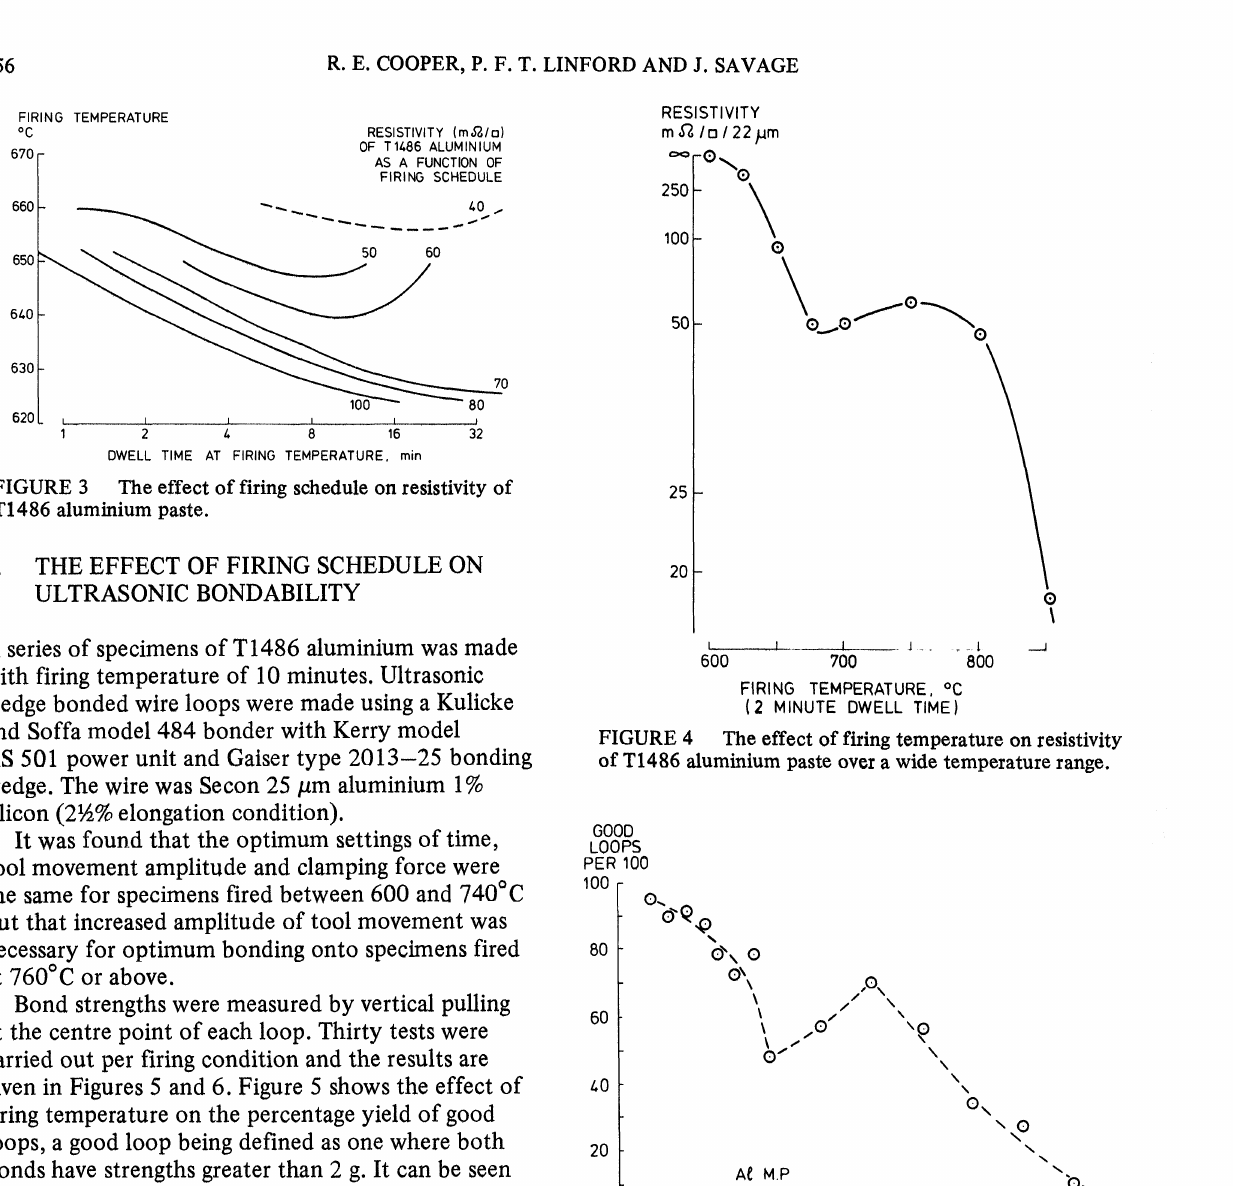
\O Variation of bondability of T1486 aluminium paste with firing temperature (10 minute dwell time).